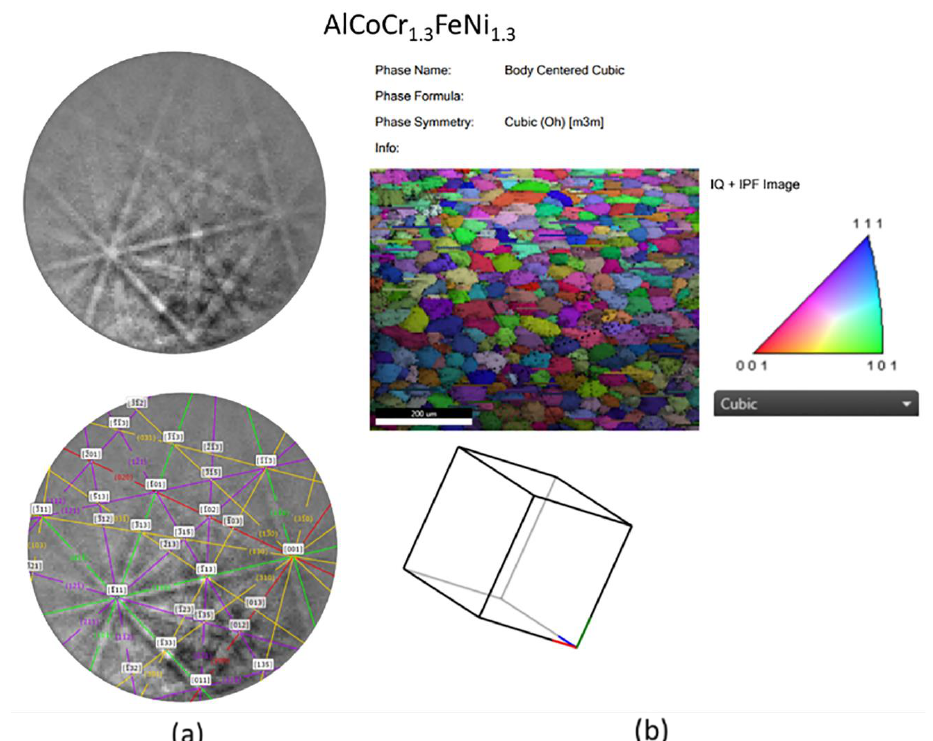
Figure 7. ( a ) Kikuchi pattern, and ( b ) IPF map and grain orientation distribution is shown for high entropy alloy AlCoCr 1.3 FeNi 1.3 . The alloy exhibited body centered cubic crystal structure as revealed in Kikuchi pattern and also XRD patterns also confirm the BCC type crystal